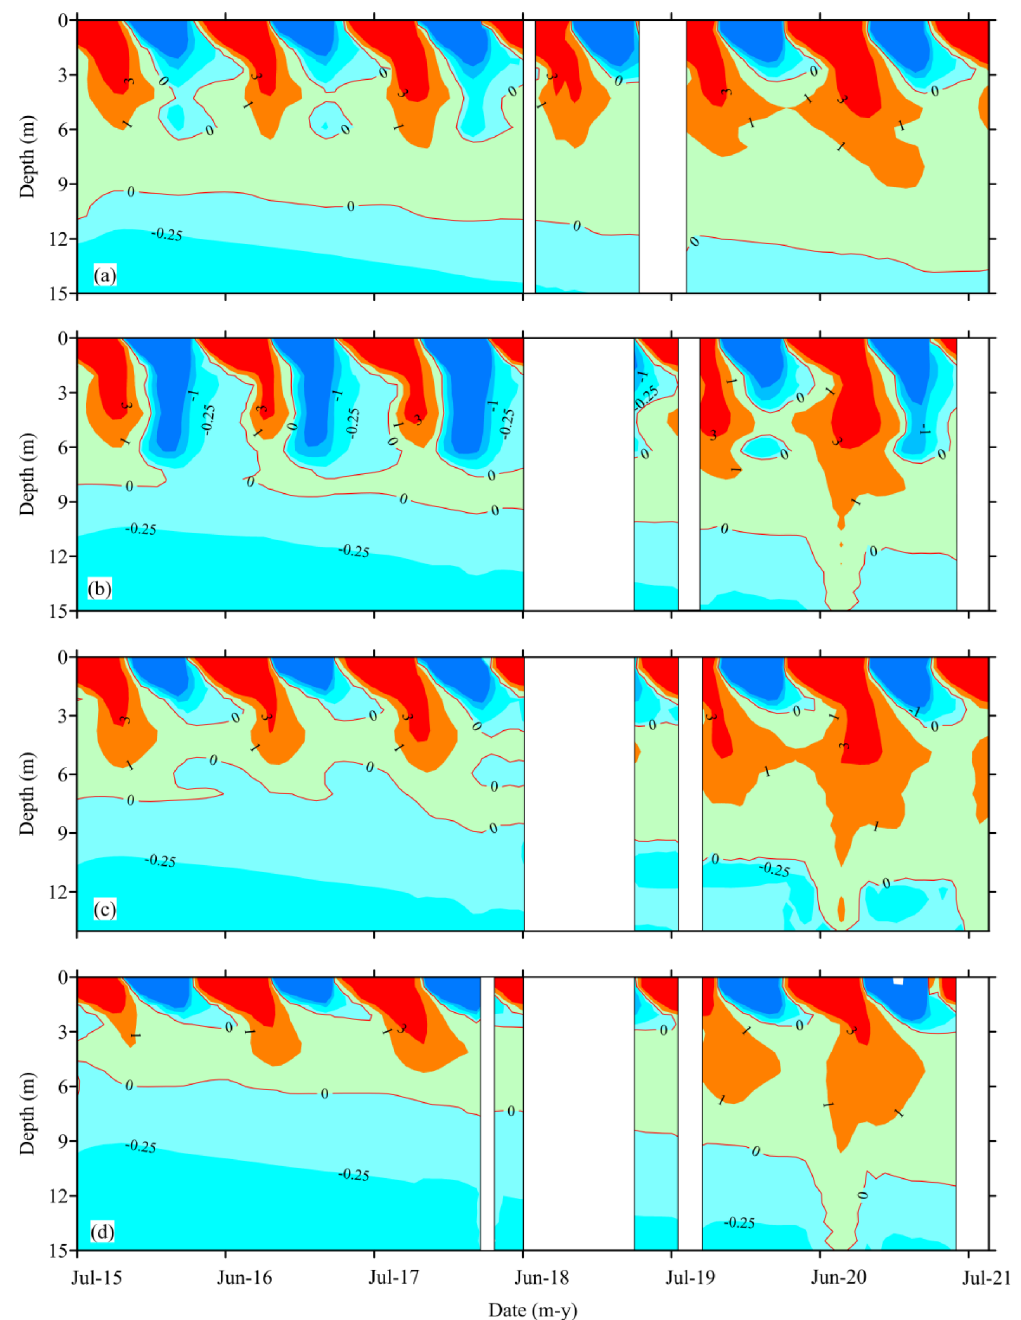
Figure 9. Depth–time contour plots of ground temperature ( ◦ C), derived from the boreholes (a) JB-B-2, (b) JB-B-3, (c) JB-B-6 and (d) JB- B-9 at the JB site along the China–Russia crude oil pipeline (CRCOP) I in the northern part of Northeast China. The blank gap indicates the missing